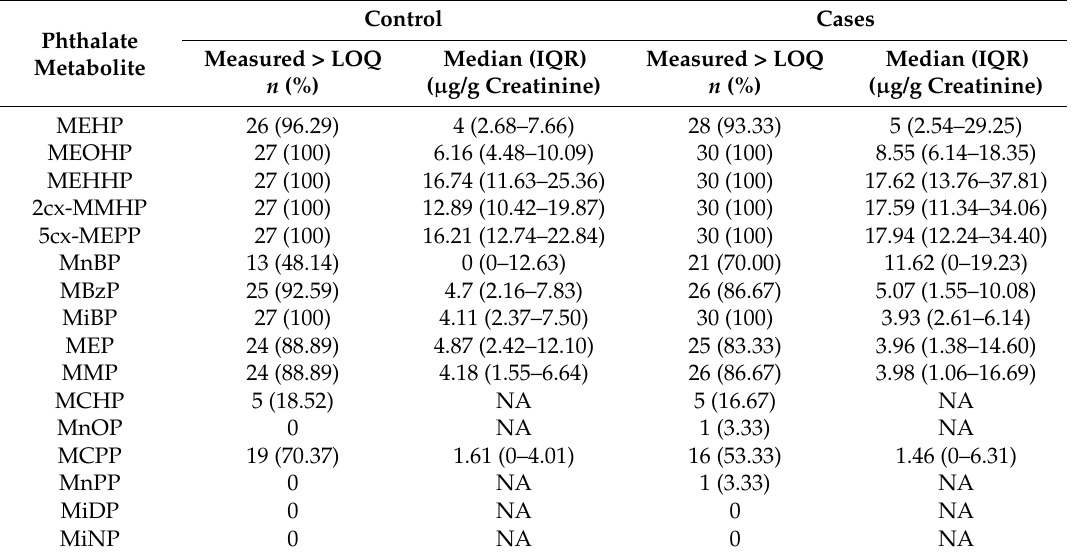
Table 2. Laboratory measurement of urinary phthalate metabolite concentrations and distribution by case status.